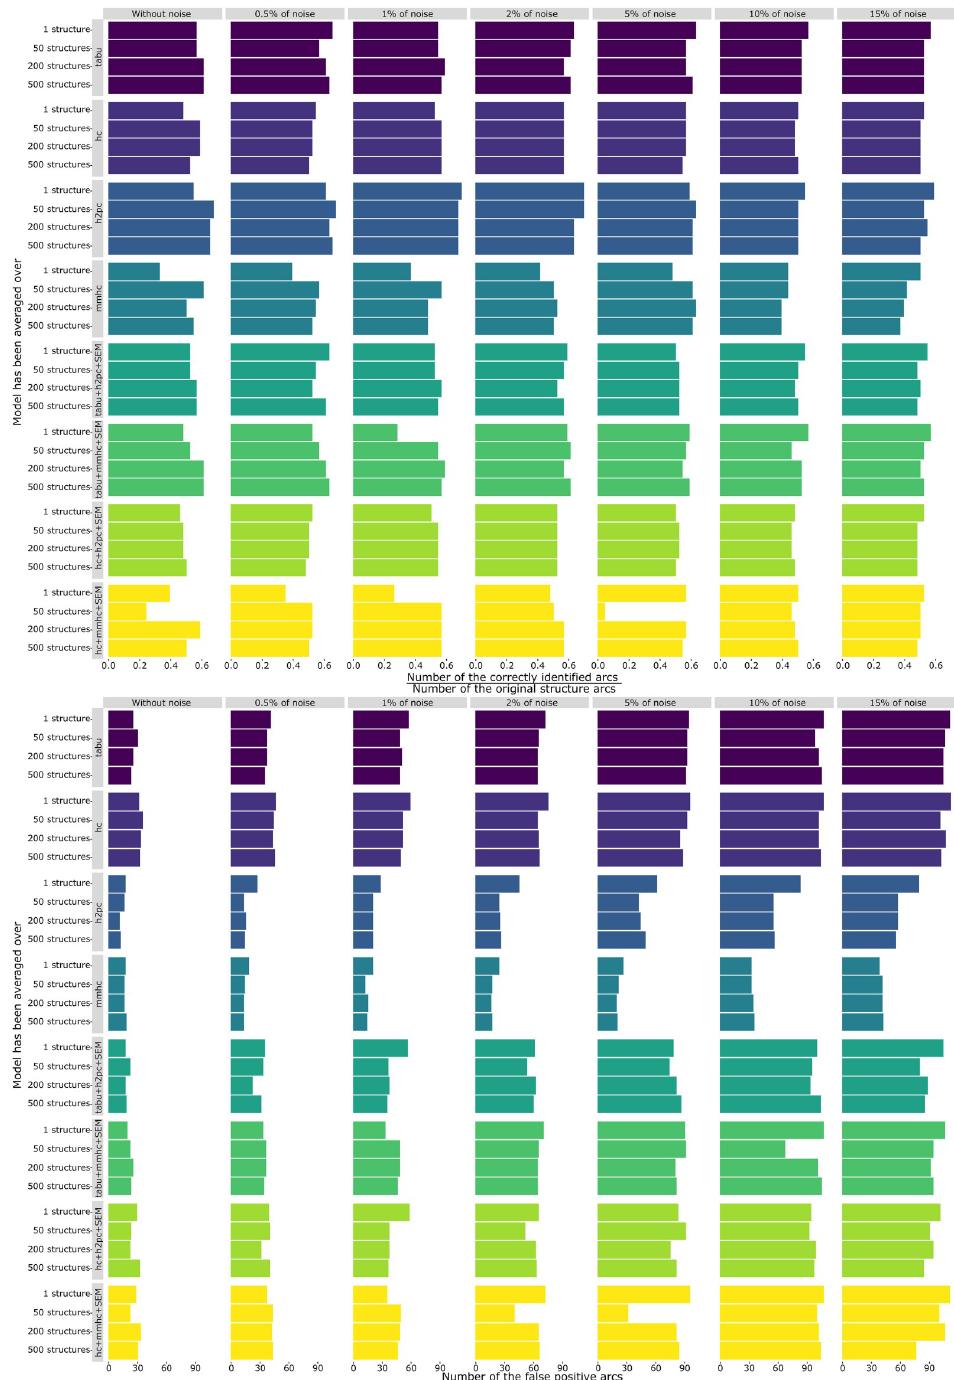
Fig 2. Results of the over-fit testing on the synthetic dataset ALARM. Source : [63]. N = 20 000 observations. Notes : The two-step approach was used to balance the structures. The over-fitting was tested on the original dataset and on the same dataset with an increased percentage of noise (i.e., 0.5%, 1%, 2%, 5%, 10% and 15% of noise). Eight rows on the top show the accuracy of the models in identifying the correct arcs. Thus, longer bars display higher accuracy. On the bottom, the rows show the number of falsely identified arcs. The shorter the bar the better as it signifies lower over- fitting.